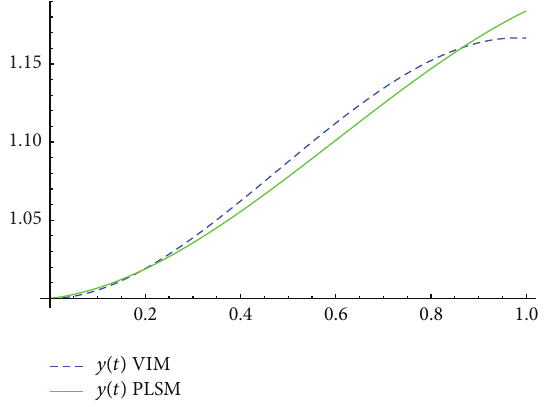
Figure 1: Approximations for 𝑥(𝑡) in the case 𝛼 1 = 𝛼 2 = 0.98 . Figure 2: Approximations for 𝑦(𝑡) in the case 𝛼 1 = 𝛼 2 = 0.98 .